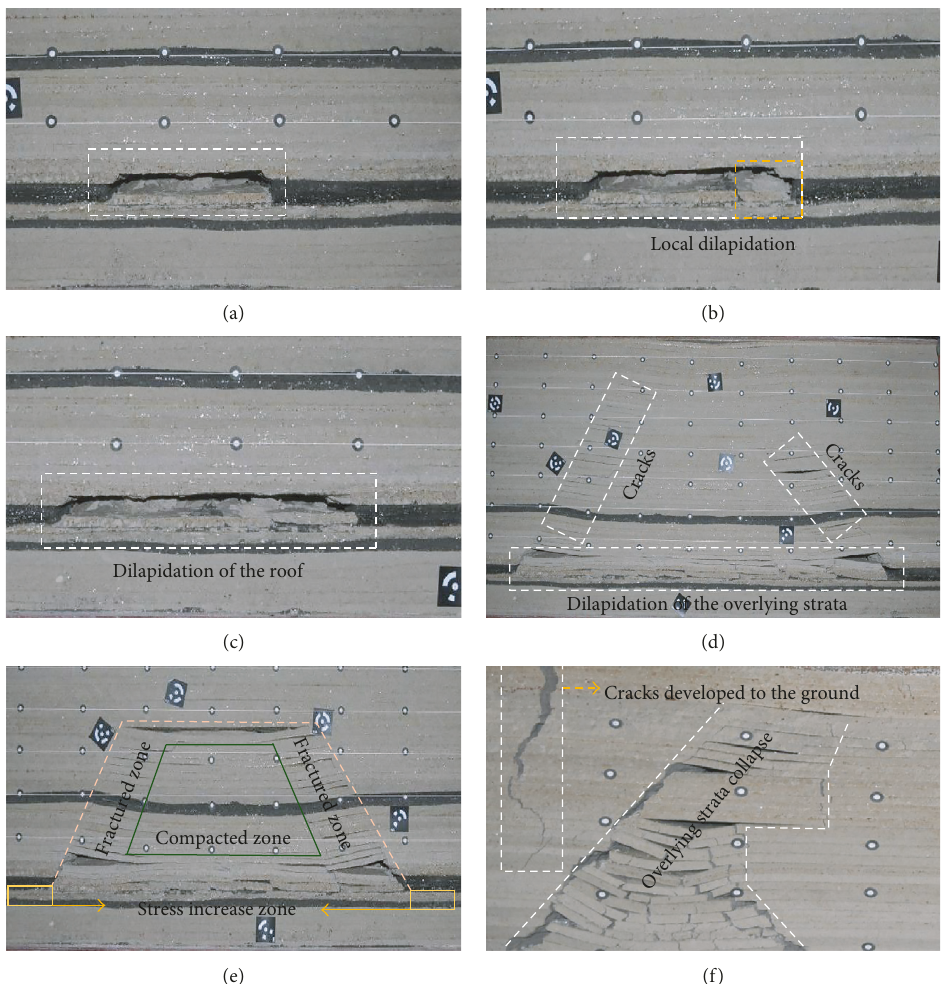
Figure 9: Progressive fracture and deformation of the overlying strata during the mining of the working face. (a) Mining up to 4 m, (b) mining up to 8m, (c) mining up to 20 m, (d) mining up to 40m, (e) mining up to 100m, and (f) mining up to